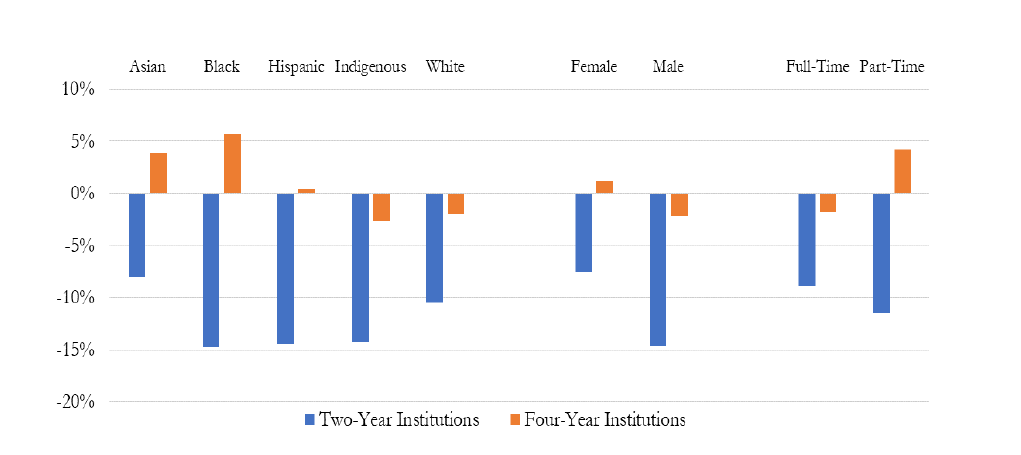
Figure 2: Percent Change in Undergraduate Enrollment by Subgroup, Fall